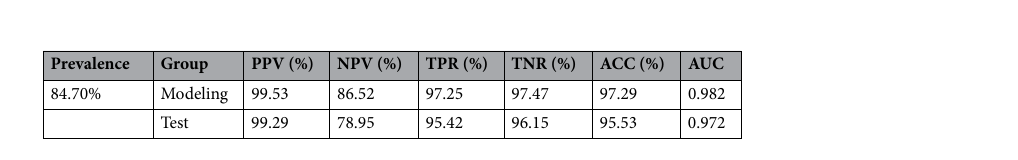
Table 2. Predicting performance of the